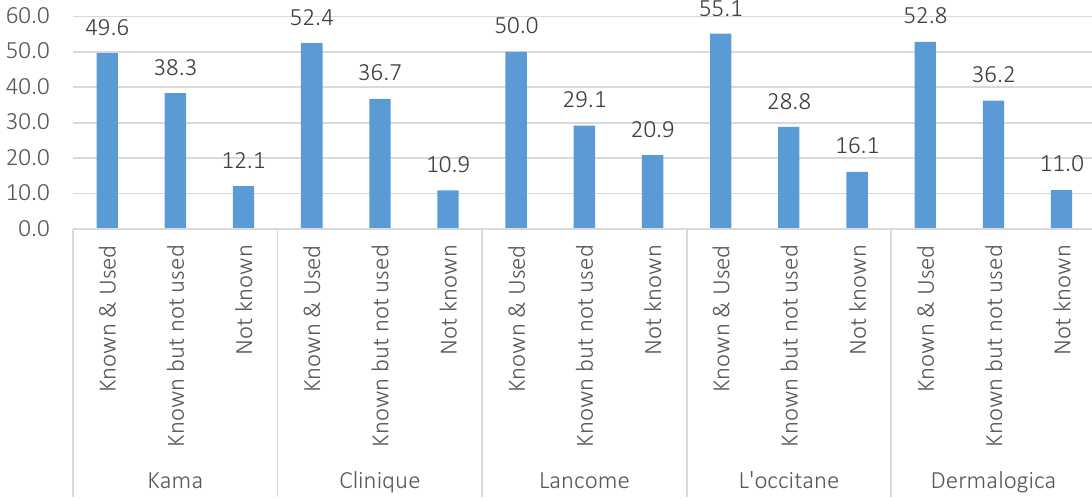
Figure 4. Background analysis on knowledge of luxury